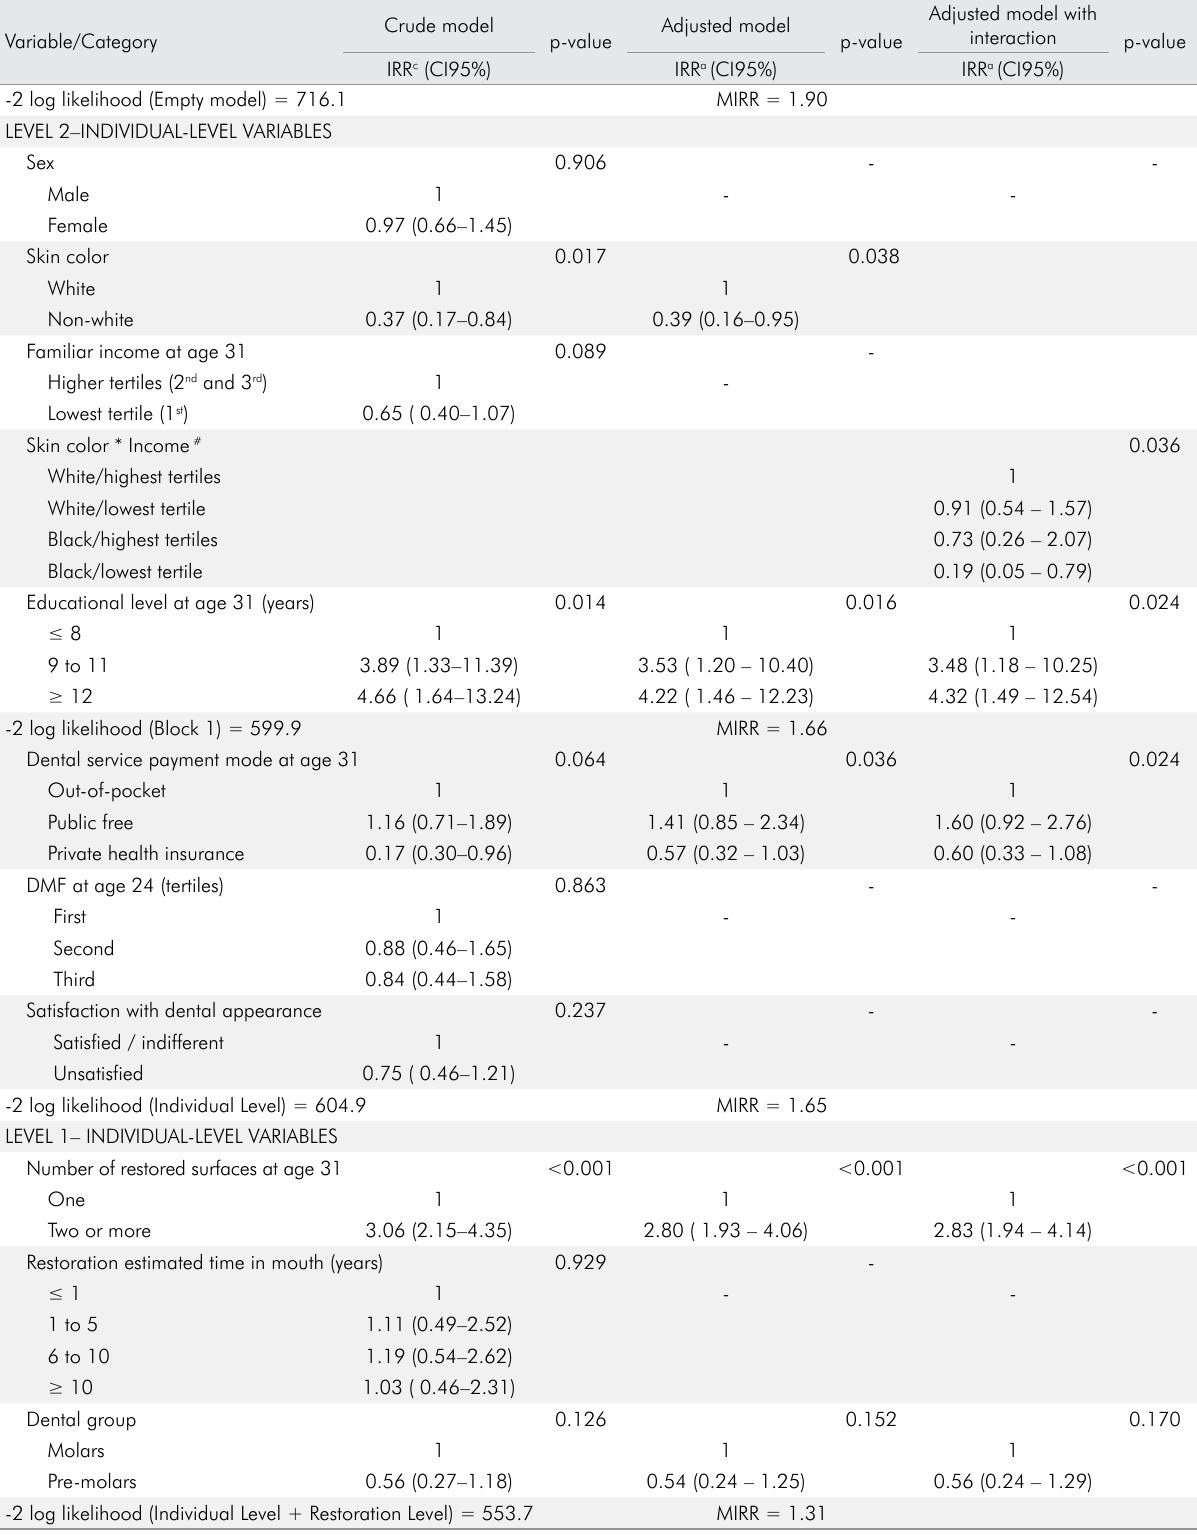
Table 2. Crude (c) and adjusted (a) risk ratio (RR) for replacement of amalgam restorations with composite resins in a sample of young adults, according to individual- and tooth-level variables. Pelotas, RS, Brazil. Multilevel analysis (n = 246 individuals; 718 restorations).